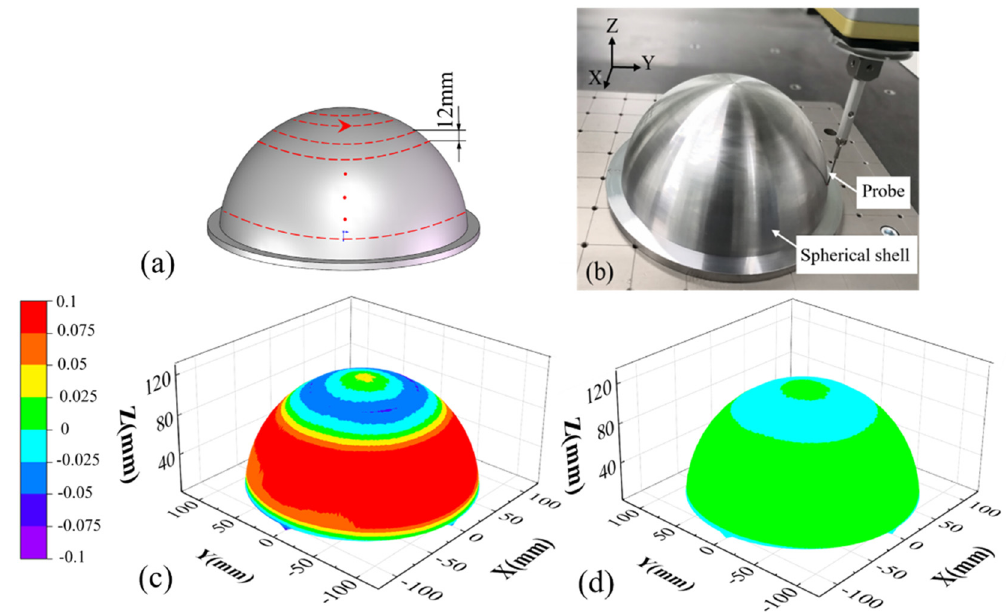
Figure 12: ( a ) Three - dimensional measurement path, ( b ) measurement setup, and the experimental measurement results ( c ) without and ( d ) with 650°C heat treatment.